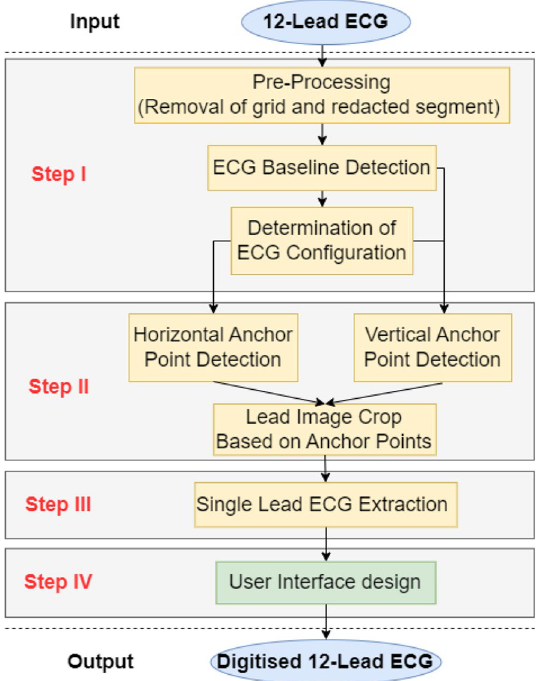
Figure 1. Overview of the automated ECG digitisation algorithm: Step I: The 12-lead ECG image is pre- processed to remove redacted portions of the ECG and the ECG grid. The ECG baselines are then determined to obtain the ECG configuration, aided by vertical anchor points. Step II: After determining horizontal and vertical anchor points and lead configuration, the 12-lead signals are cropped. Step III: ECG signal extraction from the single lead ECG images. Step IV: User interface design using dashboard